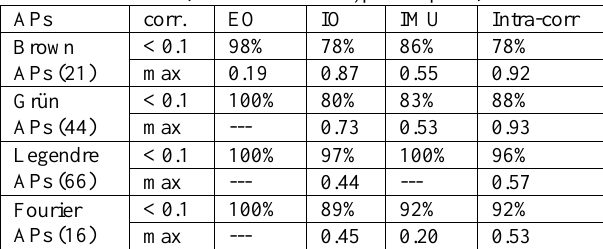
Table 1. Correlation analyses in DMC (GSD 20cm) in-situ